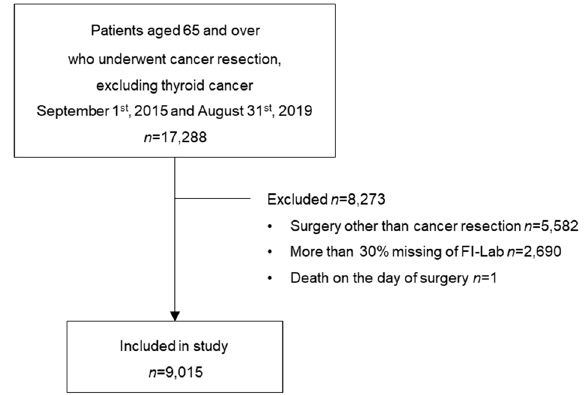
Figure 1. Selection of study patients. FI-Lab Frailty